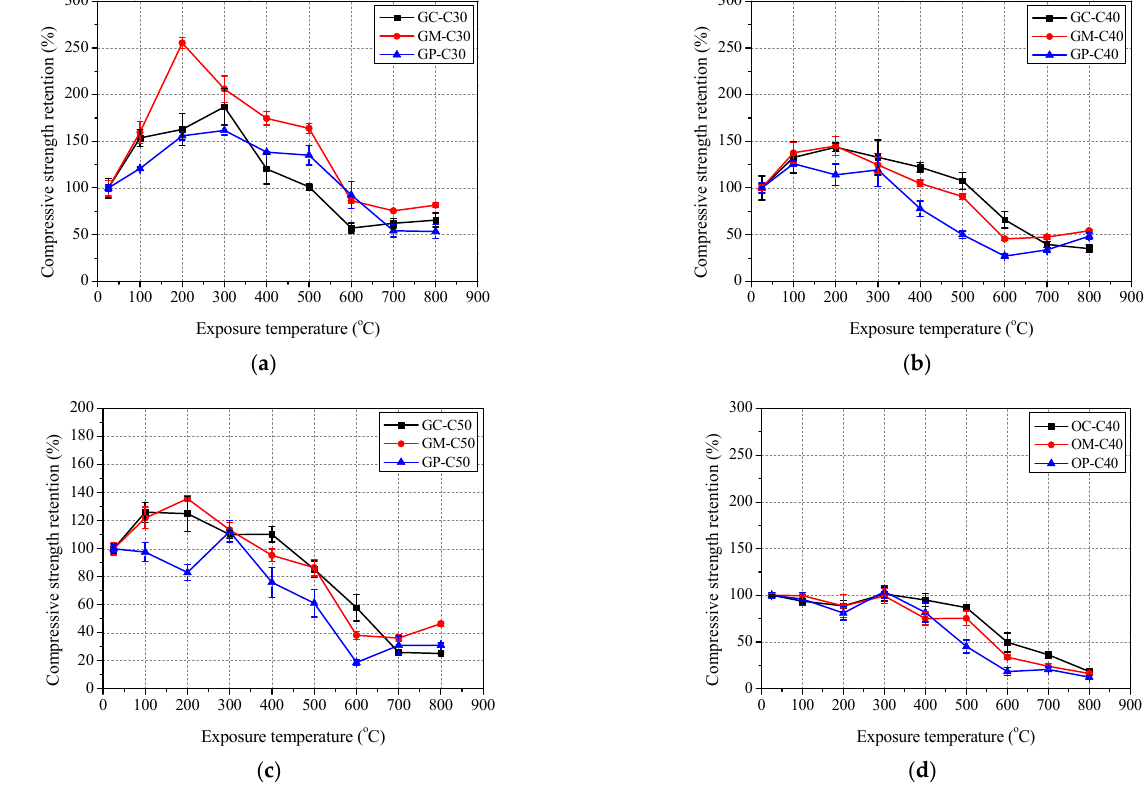
Figure 13. Comparison of compressive strength among concrete, mortar and paste after exposure to elevated temperature: